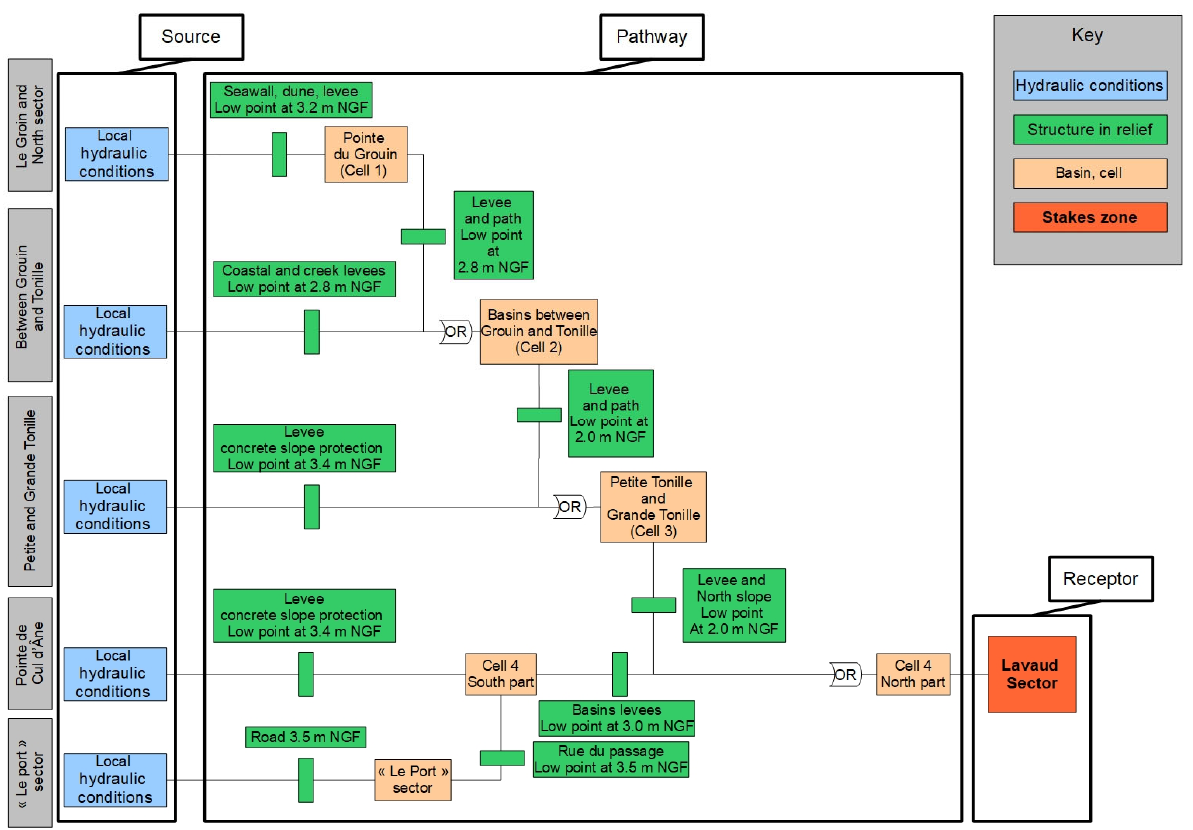
Figure 7. Synthetic flowchart of the Loix system. Altitudes are given using the NGF/IGN69 (French reference system).